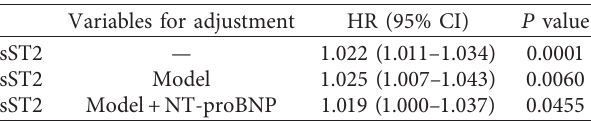
Table 2: Prognostic value of sST2 in all-cause